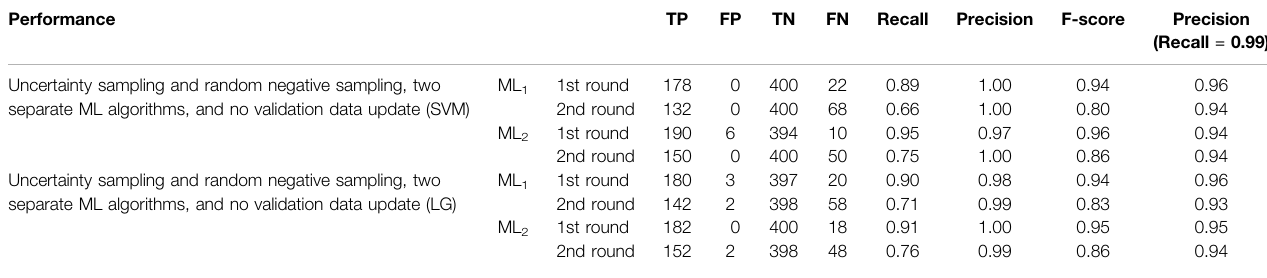
TABLE 4 | Performance (SVM and LR) of an active learning method with two separate machine learning (ML) algorithms. Performance TP FP TN FN Recall Precision